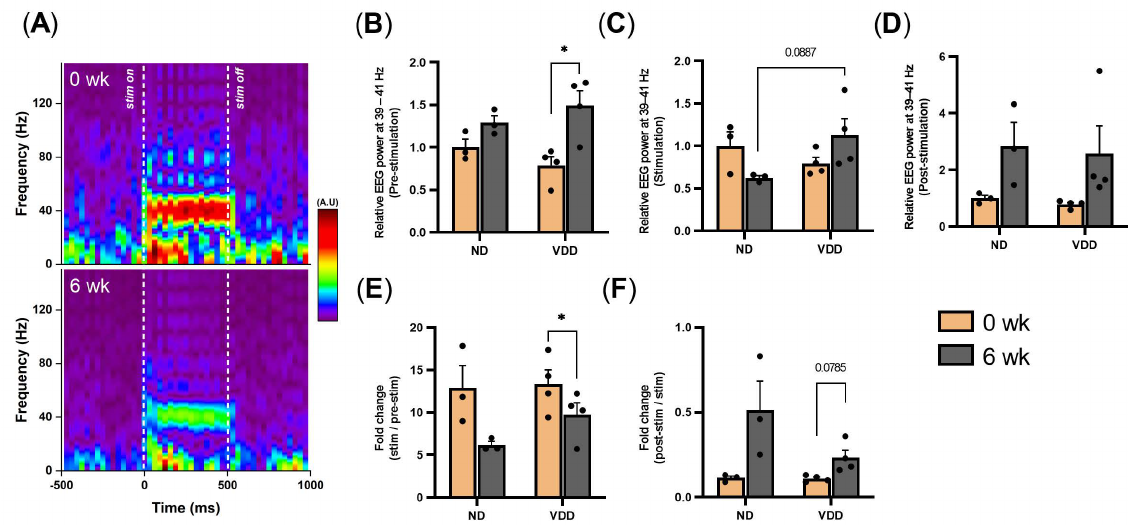
Figure 2. Optogenetically-evoked GBO reduced by vitamin D deficiency. ( A ) Representative time- frequency spectrogram of frontal electroencephalogram (EEG) from before and after vitamin D-deficient diet (0 wk, top; 6 wk, bottom). ( B – D ) Relative EEG power at 40 ± 1 Hz during the pre-stimulation, stimulation, and post-stimulation periods, respectively. ( E ) Fold change during the stimulation period in comparison with pre-stimulation period. ( F ) Fold change during the post-stimulation period in comparison with stimulation period. Data are presented as mean ± SEM. * p < 0.05 by the Student’s t